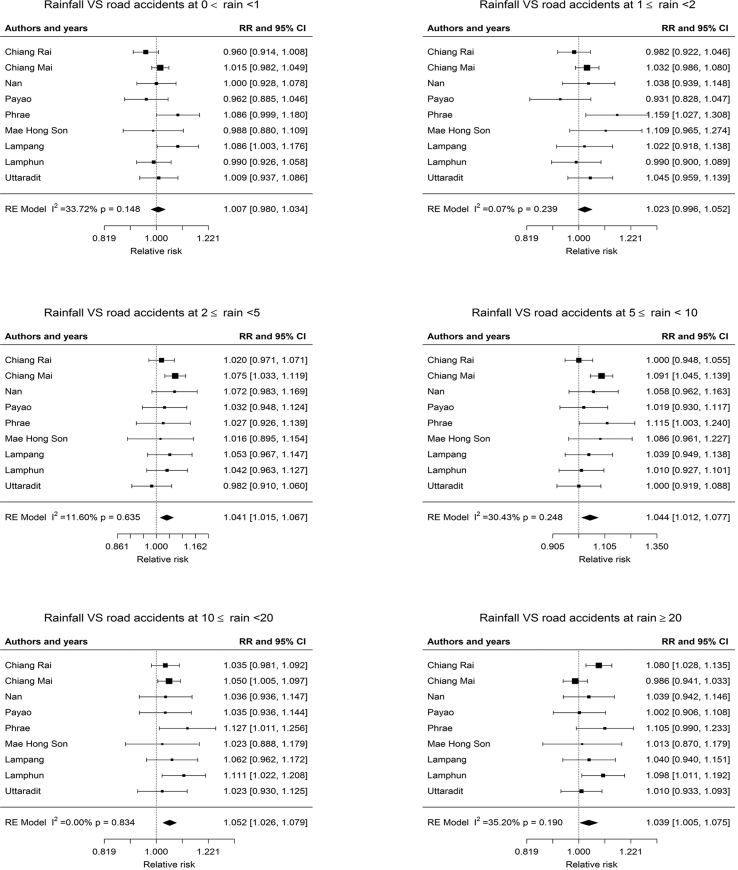
Forest plot for rainfall and road accidents at different rain volume (rain group) in the Northern provinces of Thailand.